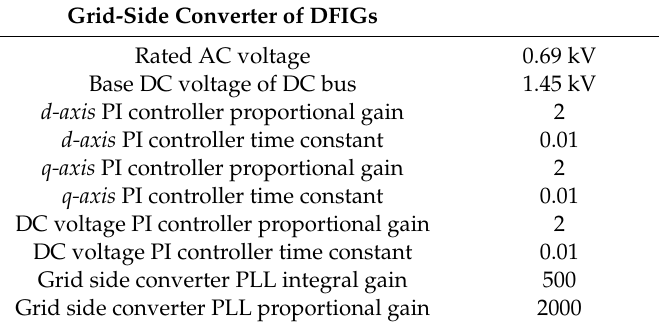
Table A2. Converter parameters and controller gains for grid-side converter of